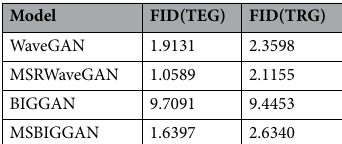
Table 5. Generative experimental